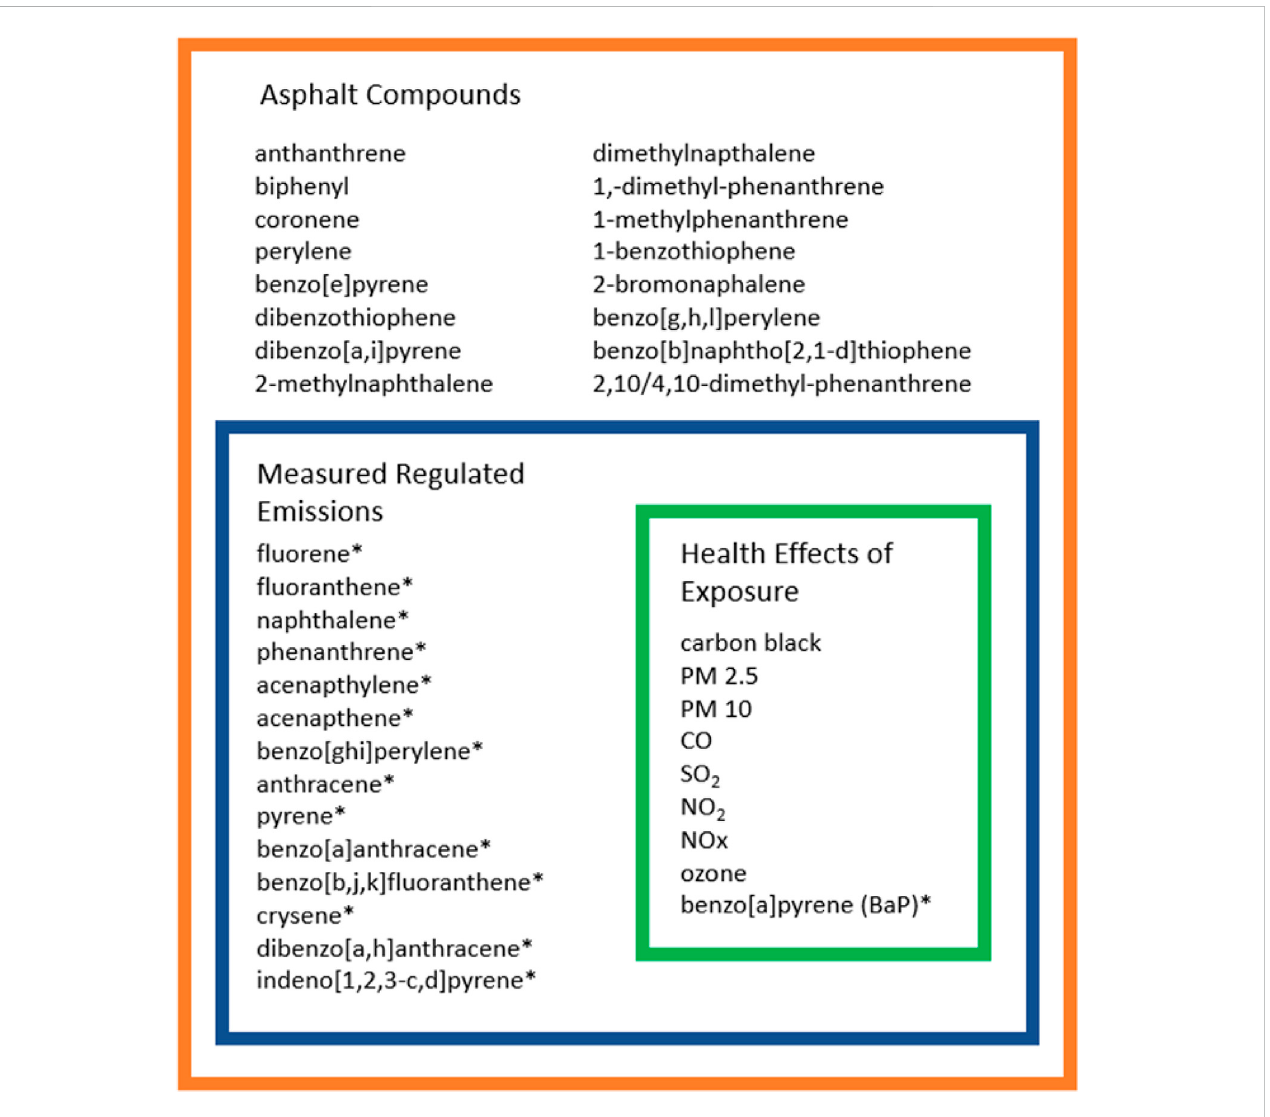
Venn diagram of asphalt compounds by regulation and health effects. The fi gure is compiled from the tables and information presented on the previous pages. The Health Effects of Exposure are the compounds associated with exposure effects. The Measured Regulated emissions box that encompasses the Health Effects of Exposure are compounds in asphalt that have regulated exposure limits. The orange Asphalt Compounds box contains the rest of the compounds that do not have exposure limit regulations as well as the compounds in the blue and green boxes. * = Compounds listed as part of the EPA list of 16 priority